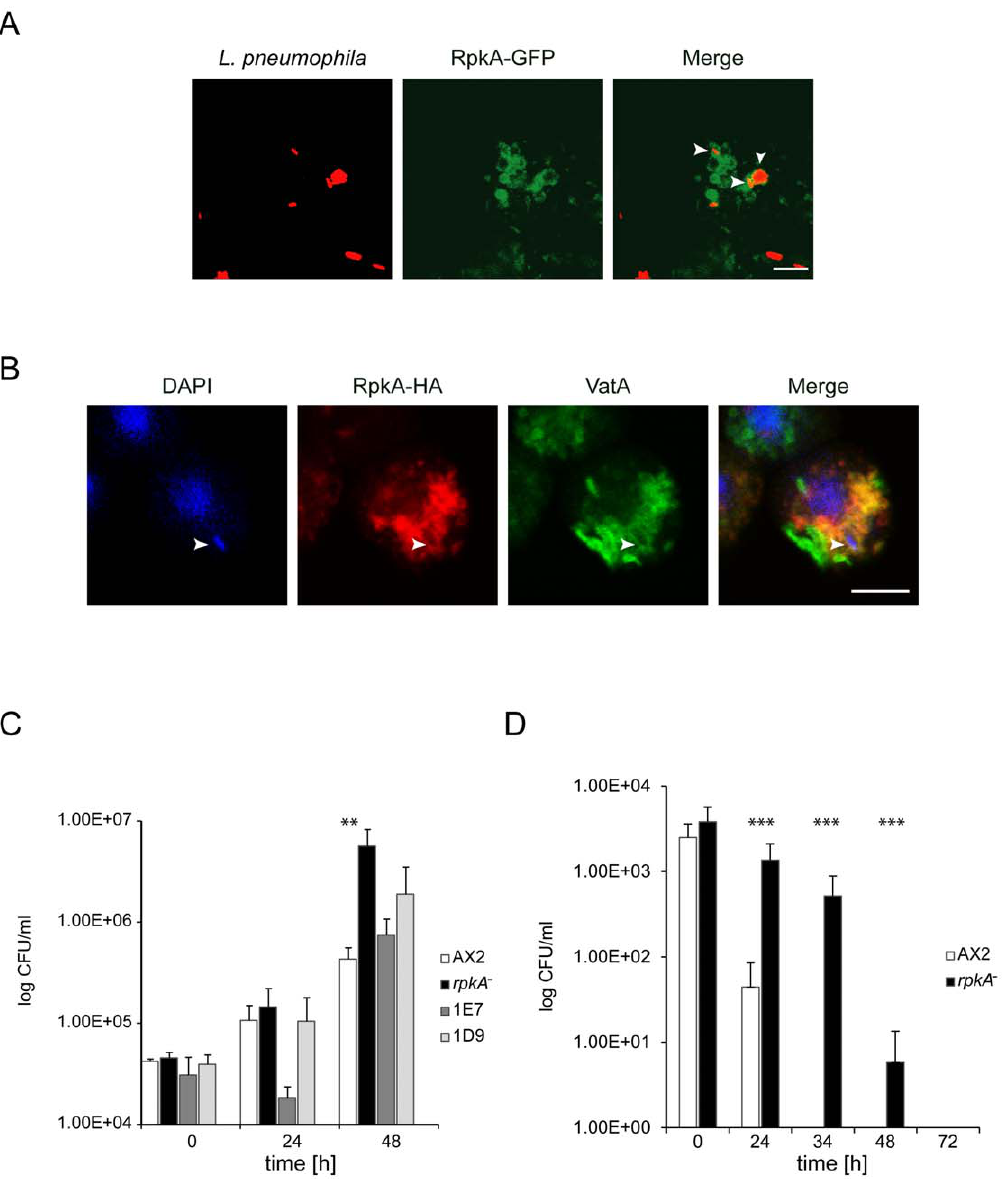
Figure 4. RpkA affects L . pneumophila infection. (A) RpkA is present on vesicles containing heat-killed L.pneumophila . AX2 cells expressing RpkA-GFP were incubated with heat killed rhodamine-labeled L. pneumophila for 10 min prior to fixation. The arrowhead points to a bacterium surrounded by RpkA labeled membrane. Bar, 5 m m. (B) RpkA and VatA are present on vesicles containing living wild type L. pneumophila . rpkA 2 cells expressing RpkA-HA (rescue strain 1E7) were incubated with living L. pneumophila and fixed after 1 h. Bacteria were visualized with DAPI, RpkA-HA with mAb 3F10 against the HA-tag and goat-anti-rat-IgG conjugated to Alexa 568 as secondary antibody. VatA was visualized with mAb 221-35-2 and goat-anti-mouse-IgG conjugated with Alexa 488 as secondary antibody. Arrowhead, V-ATPase and RpkA-HA positive vesicle containing L. pneumophila . Bar, 5 m m. (C) Loss of RpkA leads to elevated titers of L.pneumophila . AX2, rpkA - and the rescue strains 1D9 and 1E7 were infected with L. pneumophila for 3 h. Not ingested bacteria were removed and viable internal L. pneumophila